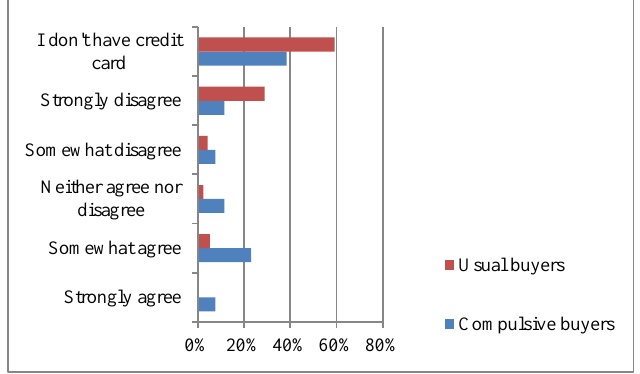
Fig. 2. “I am more impulsive when I shop with credit